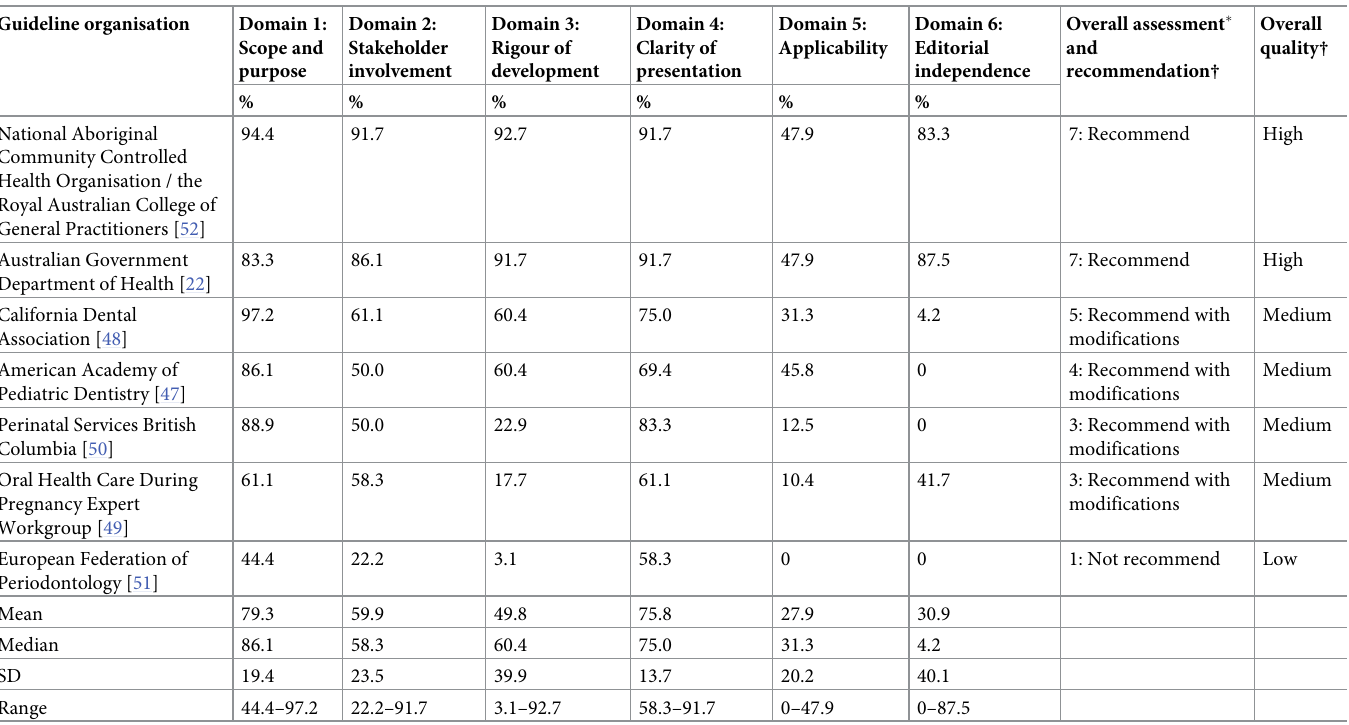
Table 4. AGREE II scores of included guidance